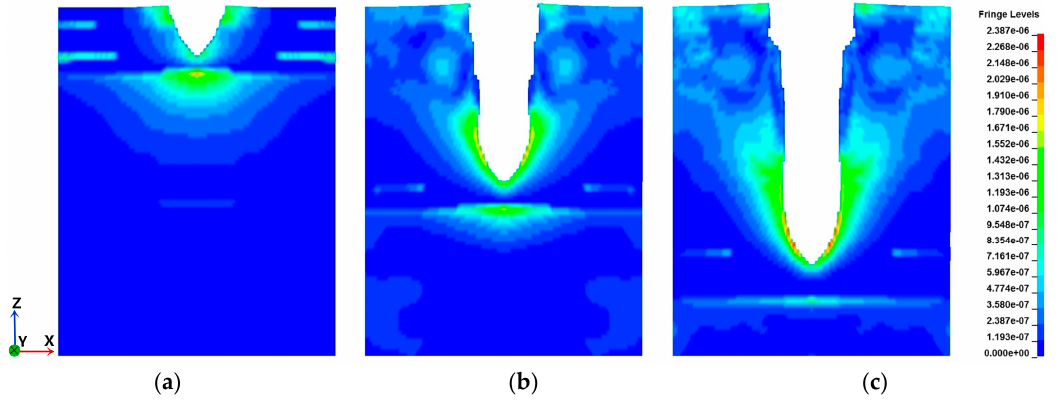
Figure 9. Stress distributions of HBS at different jet velocities. ( a ) 𝑉 (cid:3404) 50 𝑚 (cid:3401) 𝑠 (cid:2879)(cid:2869) ; ( b ) 𝑉 (cid:3404) 70 𝑚 (cid:3401) 𝑠 (cid:2879)(cid:2869) ; ( c ) 𝑉 (cid:3404) 90 𝑚 (cid:3401) 𝑠 (cid:2879)(cid:2869) . ( c ) V = 90 m · s − 1